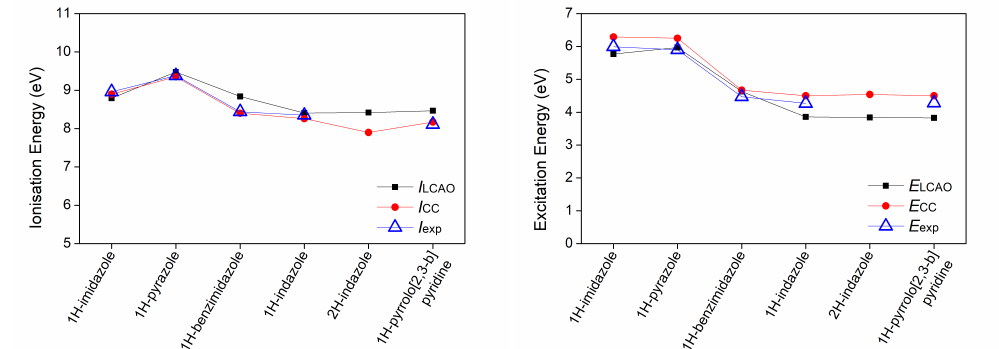
Figure 4. First π ionization energy and first π - π ∗ excitation energy of pyrimidines calculated via our LCAO method using all valence orbitals, along with results at the IP-EOMCCSD/aug-cc-pVDZ (vertical ionization energies) and CR-EOMCCSD(T)/aug-cc-pVDZ (vertical excitation energies) level of theory [29], as well as available experimental data.